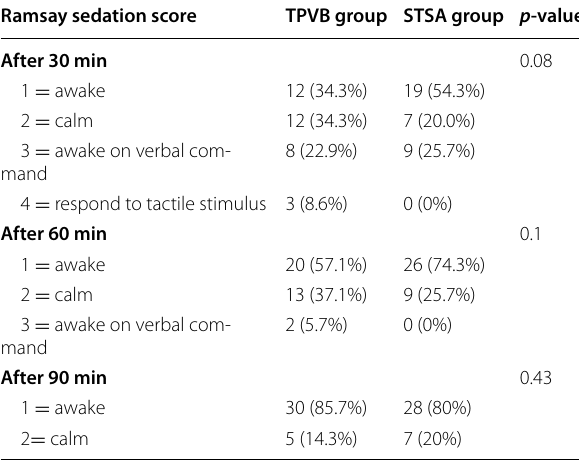
Data are expressed in number and percent ( n 1, awake, conscious, no sedation; 2, calm and compose; 3, awake on verbal command; 4, brisk response to gentle tactile stimulation; 5, awake on vigorous shaking; 6, unarousable